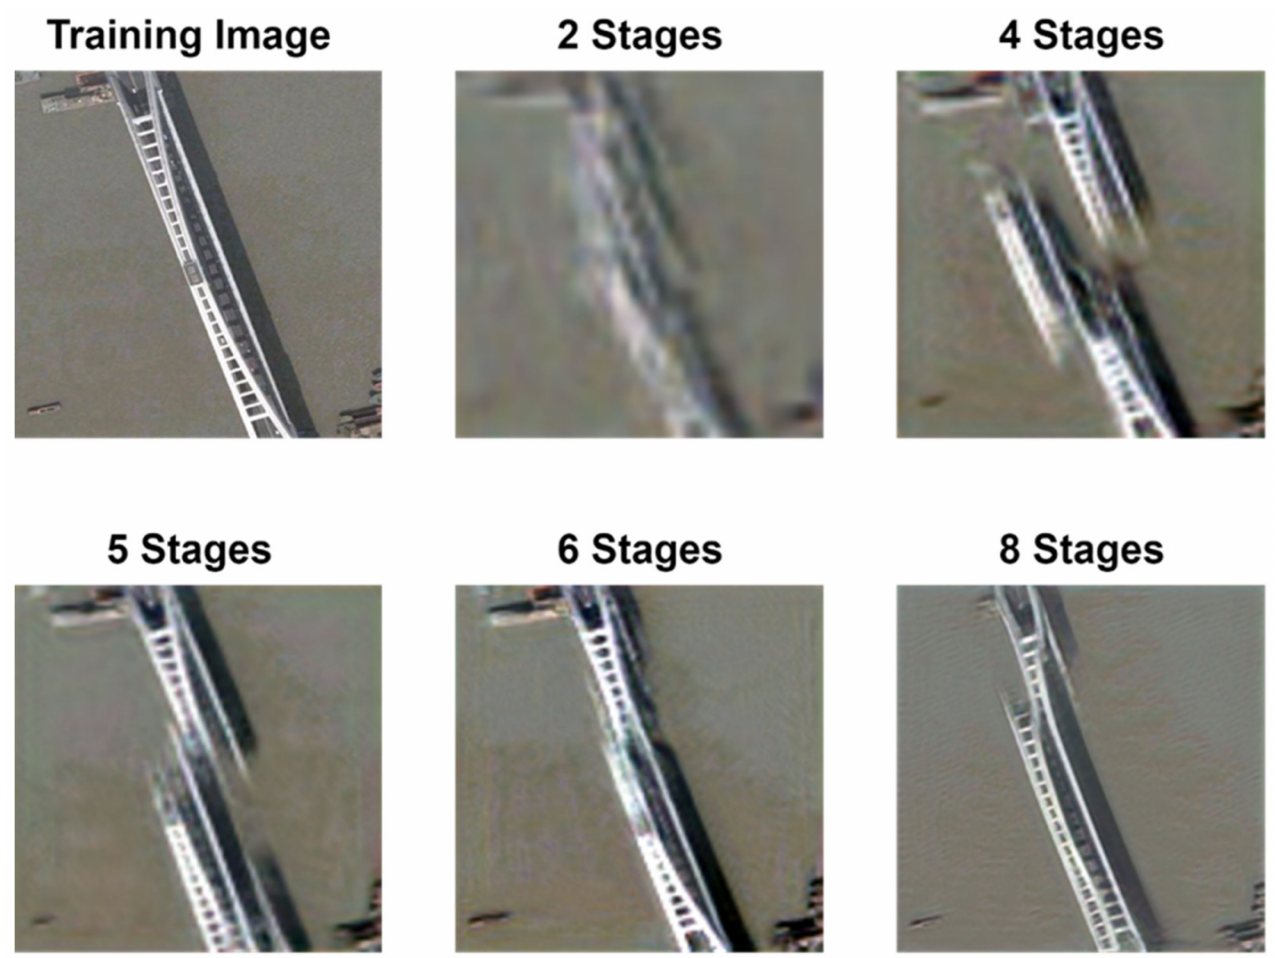
Figure 7. Effect of training with different stages by the original